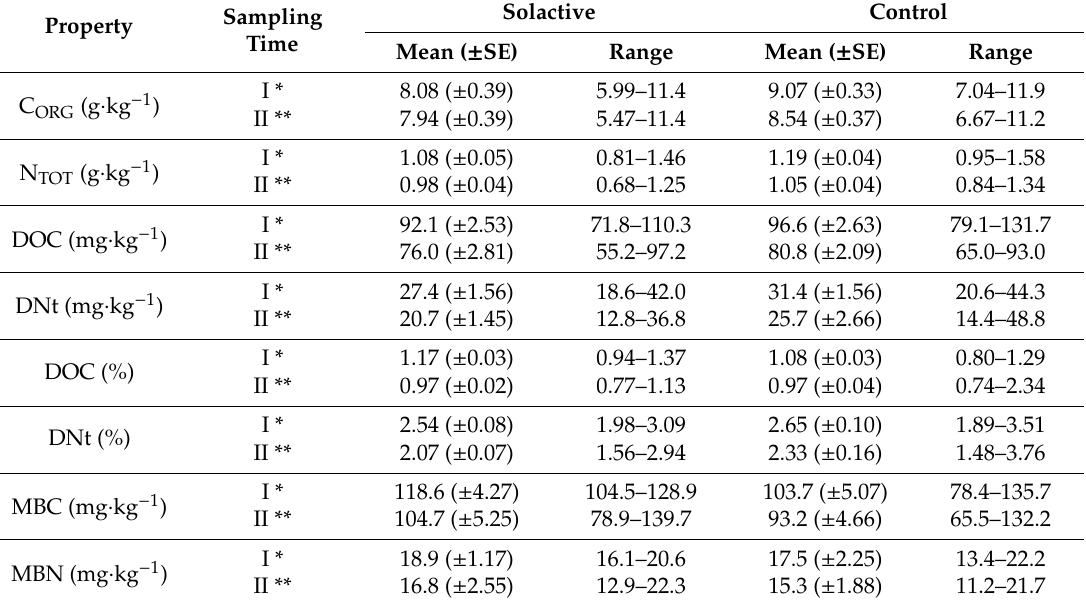
Table 2. Soil carbon- and nitrogen-related properties as a ff ected by the applied conditioner, mean ( ± SE) for the study